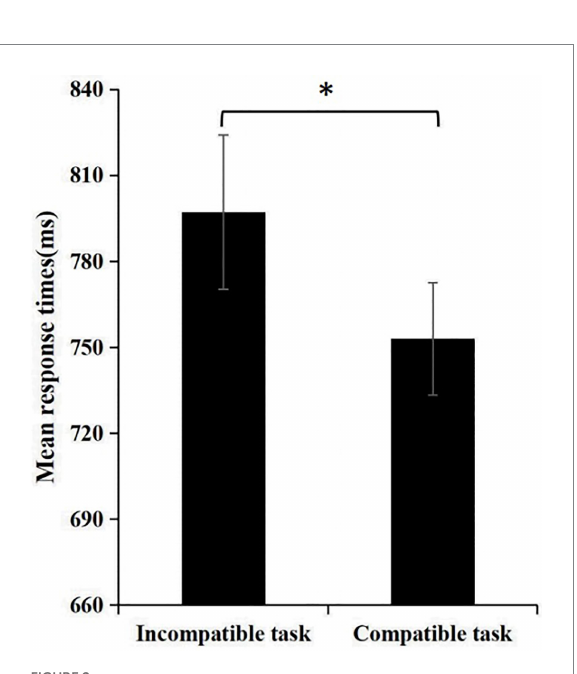
FIGURE 2 Comparison of compatible and incompatible reactions in